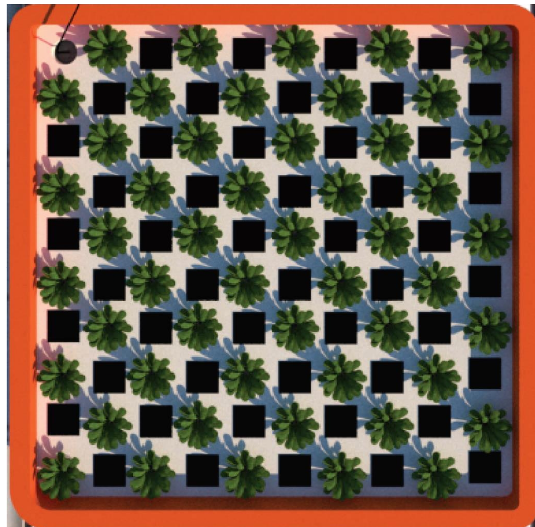
Figure 1: Pagoda mustard planting pattern.